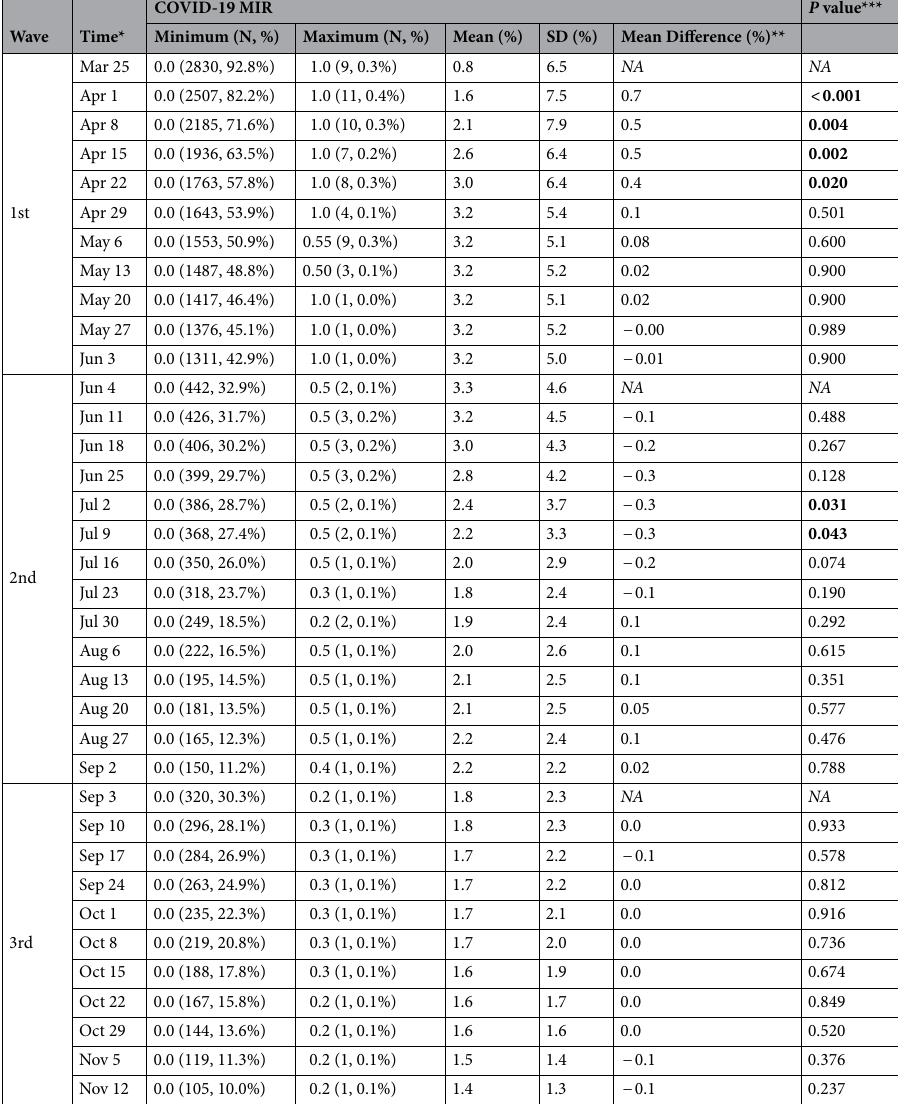
Table 1. Descriptive statistics of COVID-19 MIR in the United States for the 1st wave (Mar 25–Jun 3, 2020; n = 3050 counties), the 2nd wave (Jun 4–Sep 2, n = 1344) and the 3rd wave (Sep 3–Nov 12, n = 1055). *Year of 2020. **Mean difference between mean COVID-19 MIR at each time and the previous time. ** P values from the t test comparing mean COVID-19 MIR in each time with the previous time. Bold values are statistically significant for P <